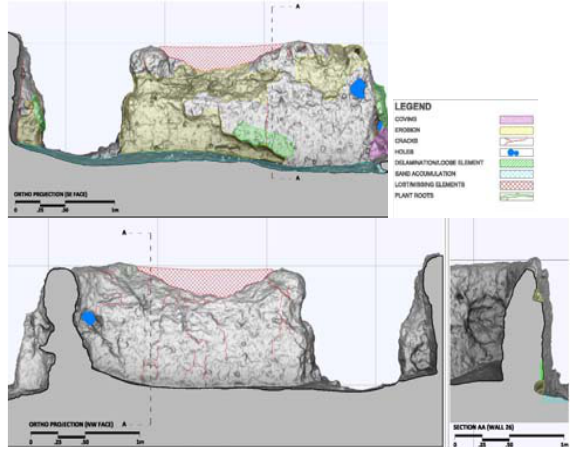
Figure 8. Using a sectional elevation extract from the laser scan to accurately map the conditions of a wall in house